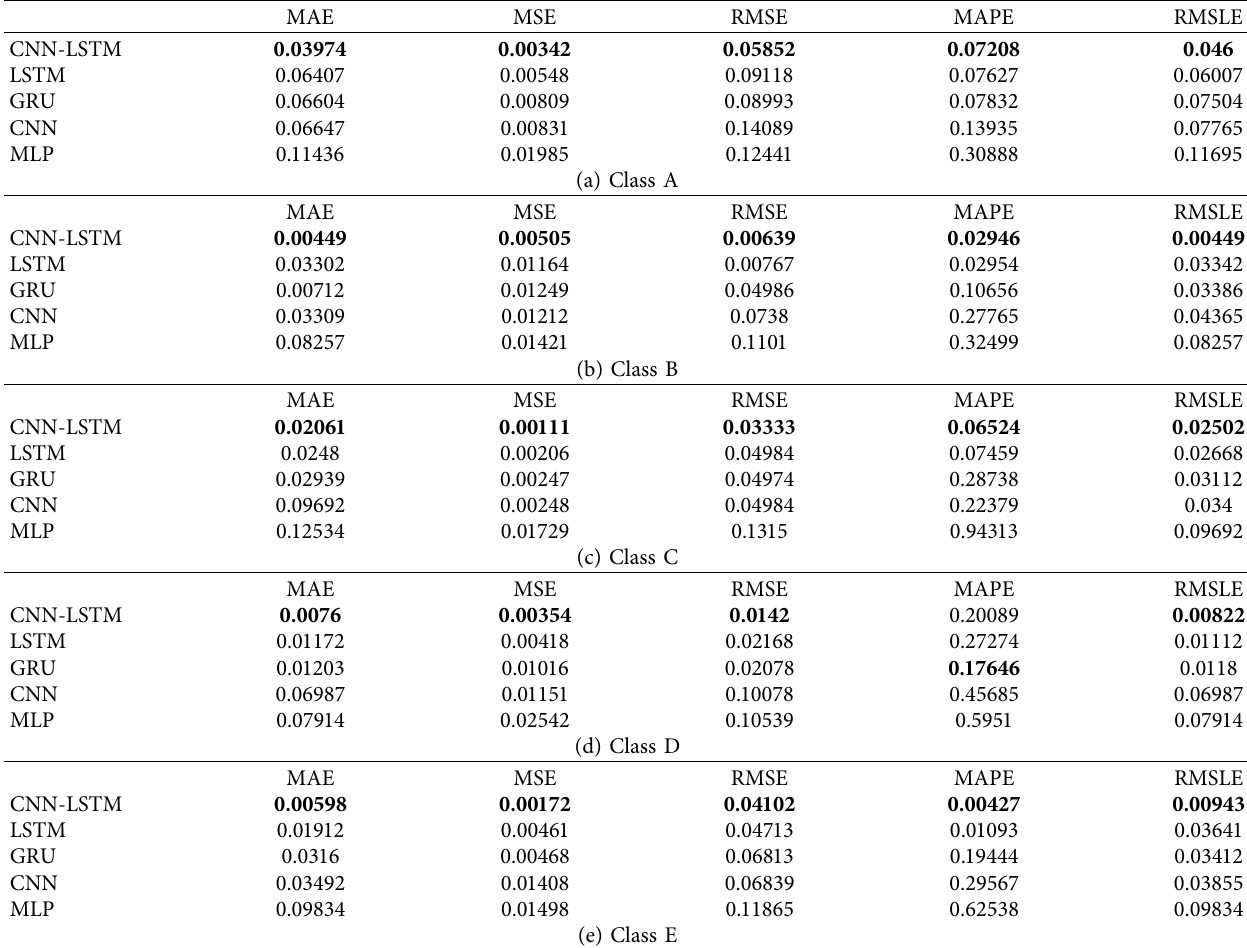
Table 11: Deep learning for historical data with weather data evaluation results.